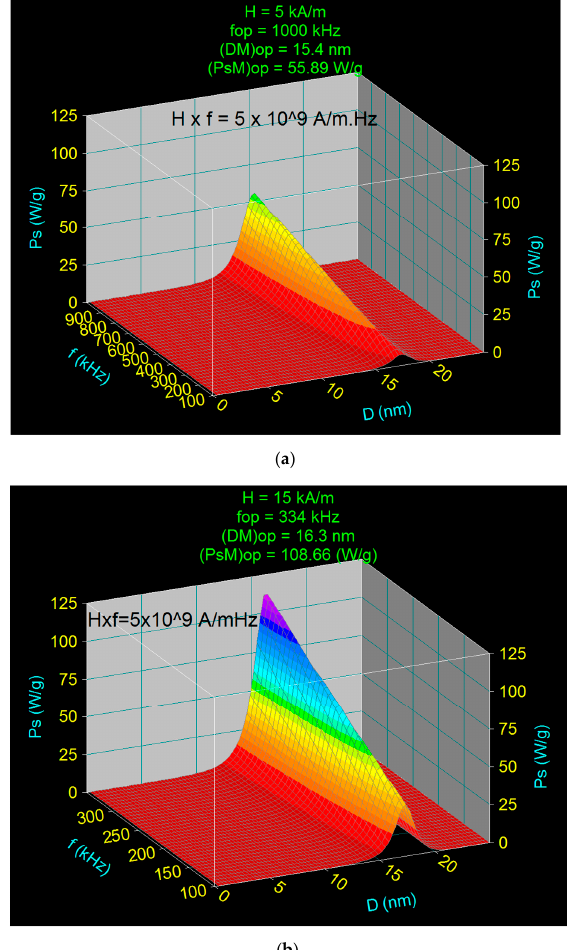
Figure 6. Optimal specific loss power within the allowable biological limit, for the magnetic field amplitude of ( a ) 5 kA/m and ( b ) 15 kA/m. From all 3D representations as in Figure 6 with the values in Table 3 for the magnetic field, all P sM and D M values were determined at the corresponding limit frequencies ( f l ). With the obtained data, the curve representing P sM as a function of the magnetic field H from Figure 7 was determined.